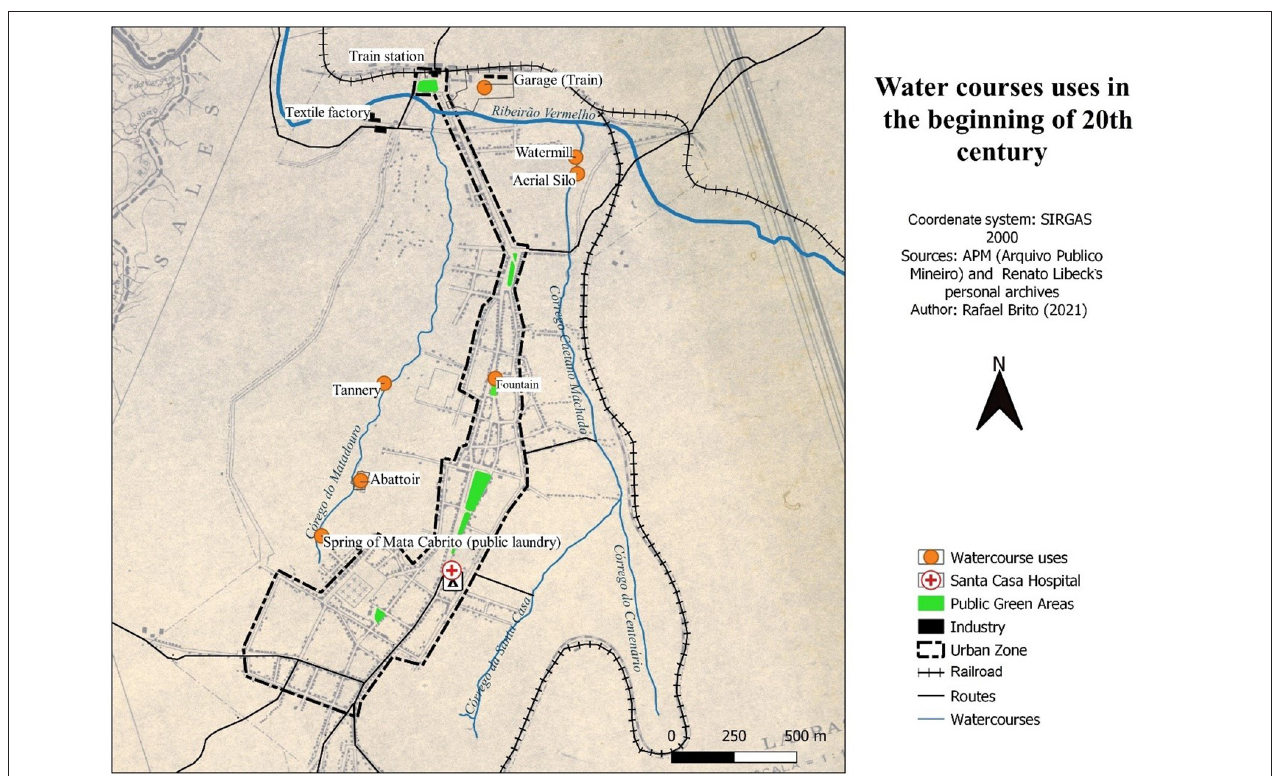
FIGURE 6 | Uses of watercourses and their surroundings until the first half of the twentieth century. Source: Sousa R. B. et al. (2021).